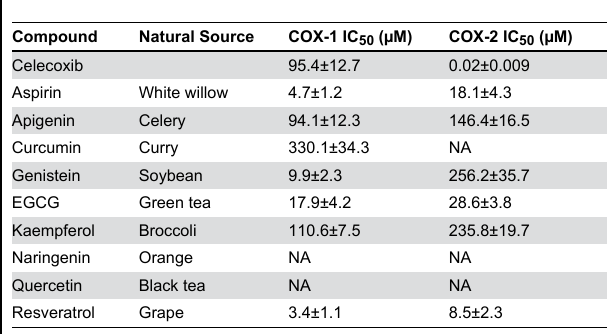
1. of COX activity by